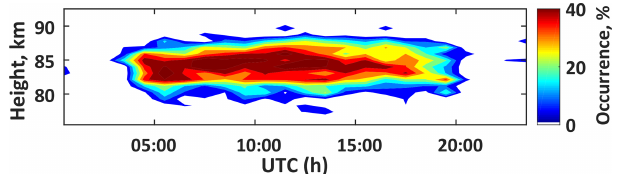
Figure 3. The 24h composites of MSE occurrences as function of UTC time and the height of detected